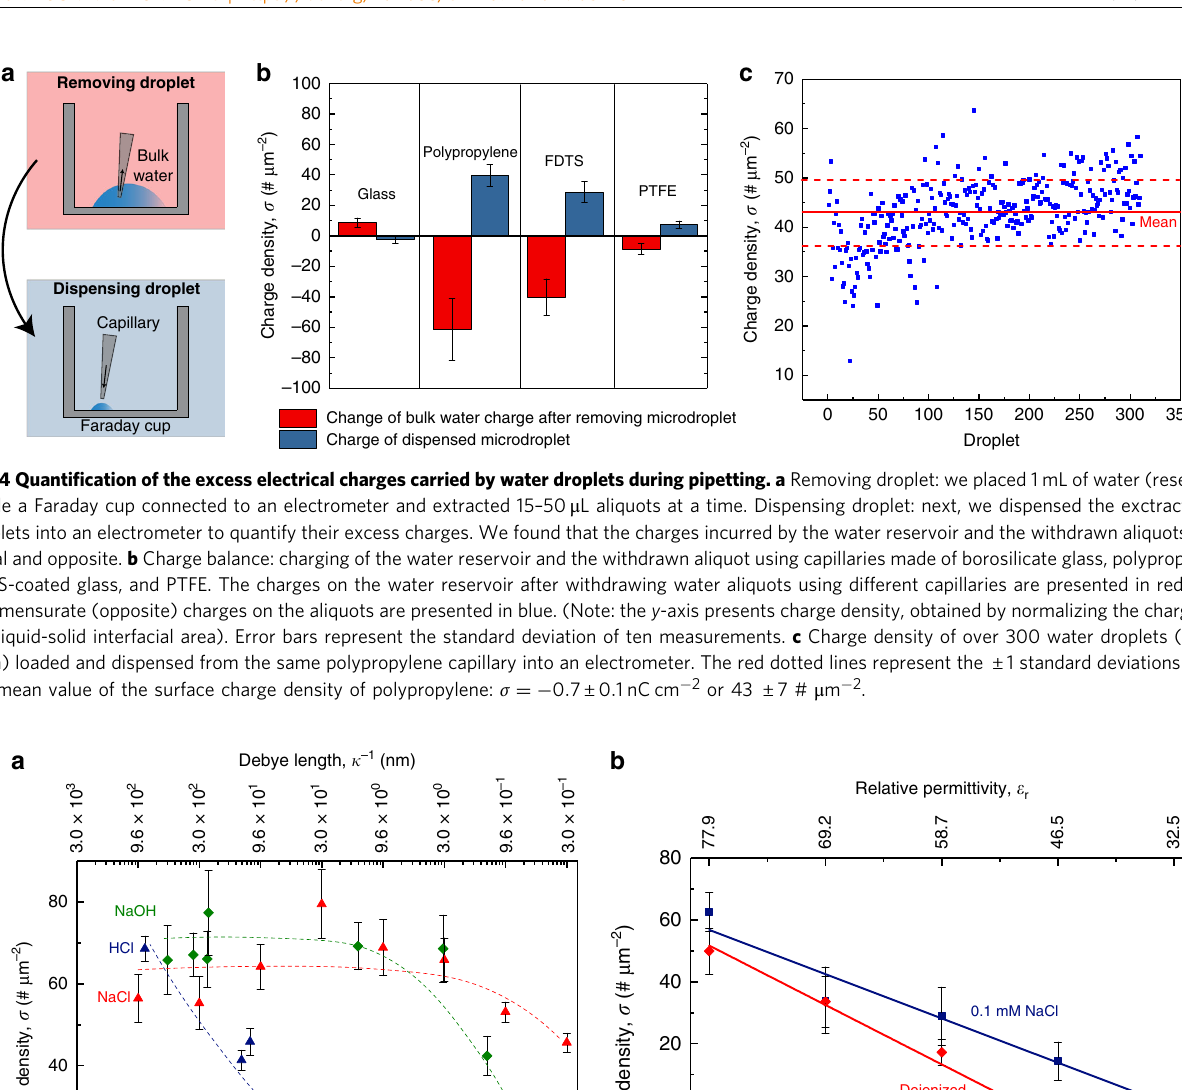
the hydrophobic capillaries decreased (Fig. 5a; see Supplementary Fig. 6A for the effects of varying ionic strength with KBr). Upon increasing the concentration of HCl, the measured charge dropped signi fi cantly below pH 4, whereas for NaCl and NaOH, the electri fi cation was unaffected up until >10 mM (Fig. 5a).